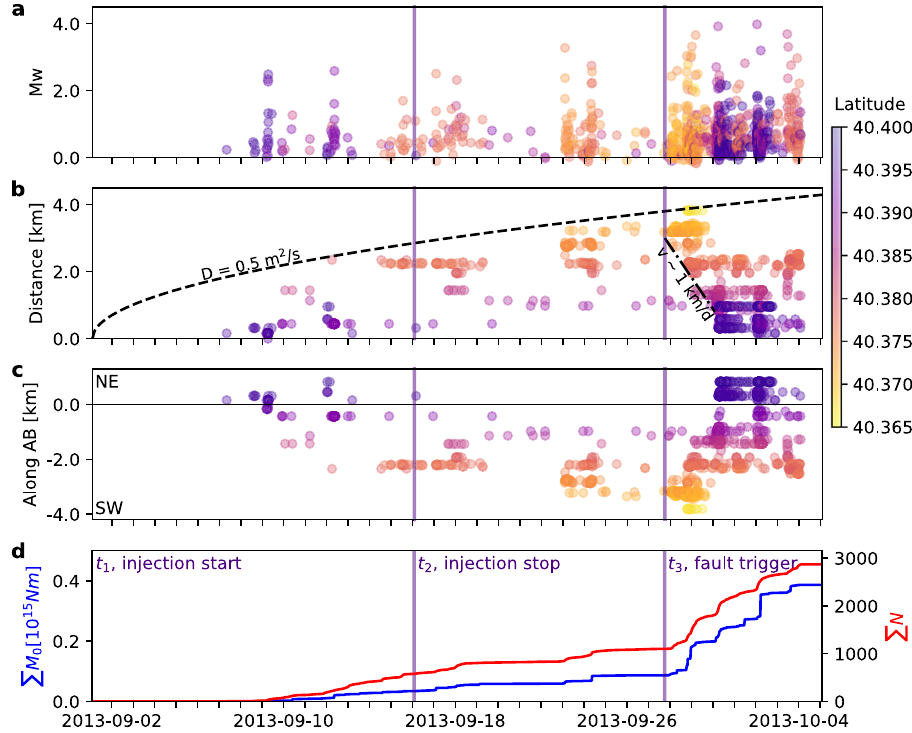
Fig. 7 Timeline of injection and seismicity. Temporal evolution of a magnitudes, b epicentral distances from the injection well, c epicentral location projections along pro fi le AB, as in Fig. 2, and d cumulative moment release and cumulative number of earthquakes for the time period from 2013-09-02 00:00 until 2013-10-06 00:00 UTC. The onset of three main phases are marked by indigo vertical bars, denoting injection start ( t 1 , 2013-09-02), injection stop (t 2 , 2013-09-17), and approximate fi rst triggering of the fault hosting largest earthquakes ( t 3 , 2013-09-28, 16:00). The color scale used in a – c refers to event latitudes (top right). A dashed line denotes the diffusion curve from the injection point at time t 1 , assuming a diffusivity of 0.5 m 2 /s, which explains the migration of seismicity during phases 1 – 2, and a dashed-dotted line the faster earthquake triggering backward propagation with a velocity of v ~ 1 km/ day during phase 3. Note that plotted seismicity corresponds to 964 events: 51 accurately relocated events (Fig. 2a) and those detected by template matching using the 51 events as templates; we attributed to detected events the same locations as their